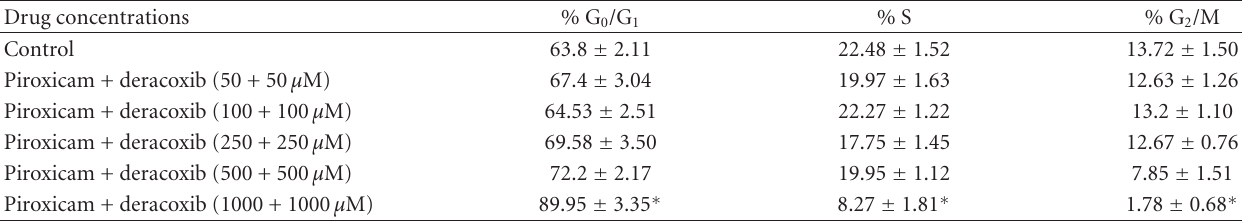
Table 2: E ff ects of piroxicam and deracoxib combination on cell cycle phase distribution of CMT-U27 cells. Data are expressed as mean values ± standard error of means shown with ∗ P < 0 . 05 versus control